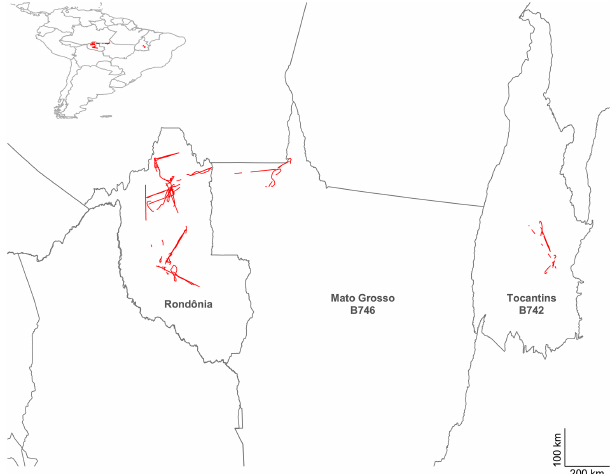
Figure 6. Flight tracks of the aircraft while sampling within re- gional haze that are included in our regional analysis. Scale in lower right-hand corner pertains to the enlarged map focussed on our study region. See Sect. 4 and Table 1 for further